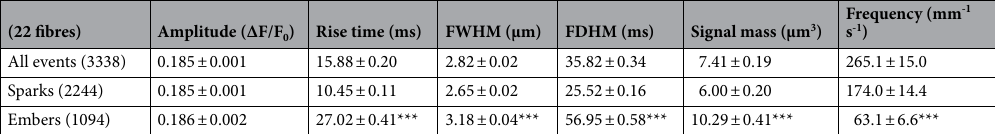
Table 1. Characteristics of honey bee elementary calcium release events detected in line-scan ( XT ) experiments. Events with less than 0.1 amplitude were discarded. All events with greater than 40 ms duration were classified as ember. The numbers in parenthesis are the number of event analysed. ***Denotes significant differences from spark, p < 0.001. FWHM – full width at half maximum, FDHM – full duration at half